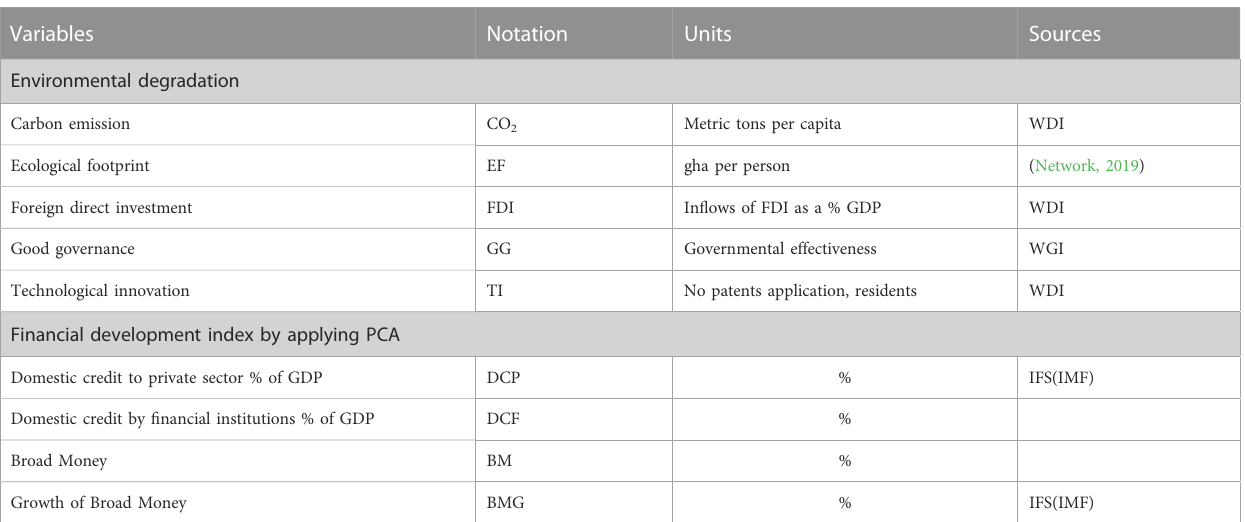
TABLE 6 Variables